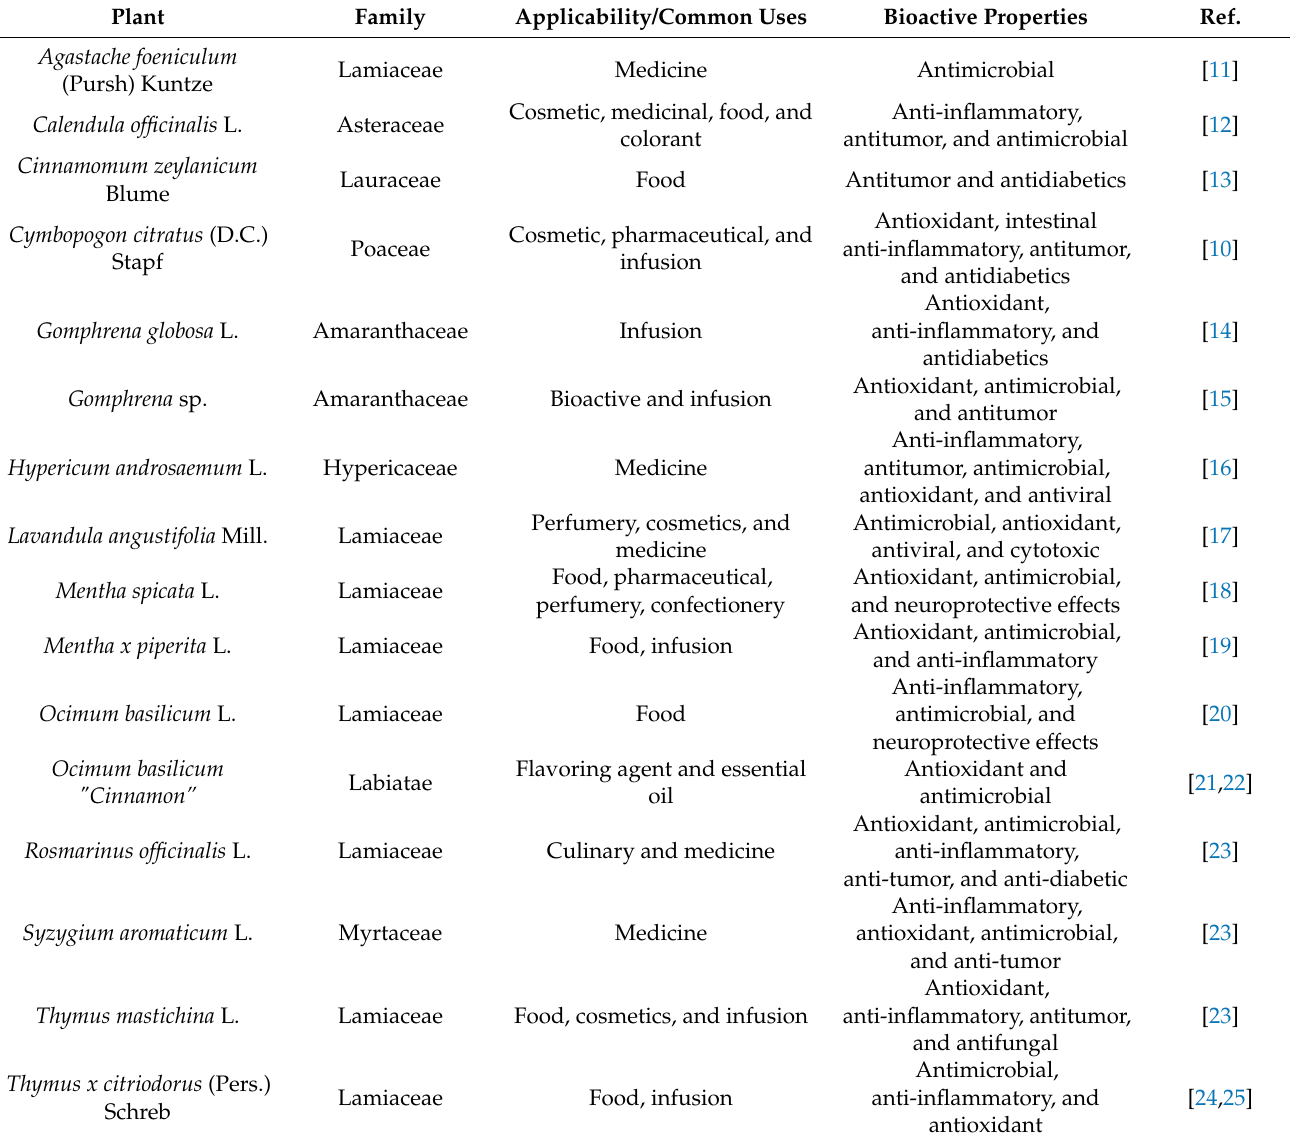
Table 1. Applicability, common uses, and biological properties of the MAPs that constituted the five samples tisanes.